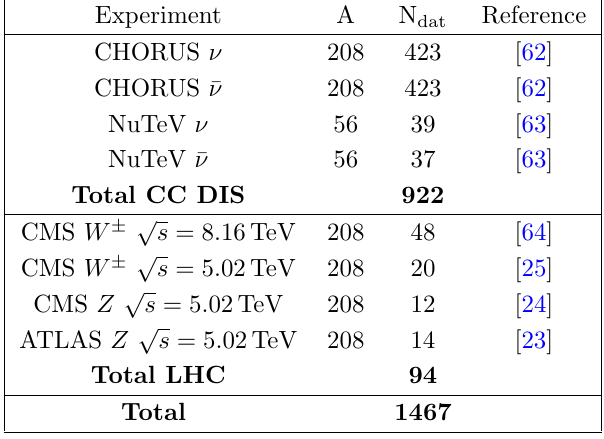
Table 2 . Same as table 1 for the new datasets that have been added to nNNPDF2.0. As opposed to the NC structure function measurements, these datasets are presented as absolute distributions rather than as cross-sections ratios. We also indicate the total number of data points in the (cid:12)t, combining the NC and CC structure functions with the LHC